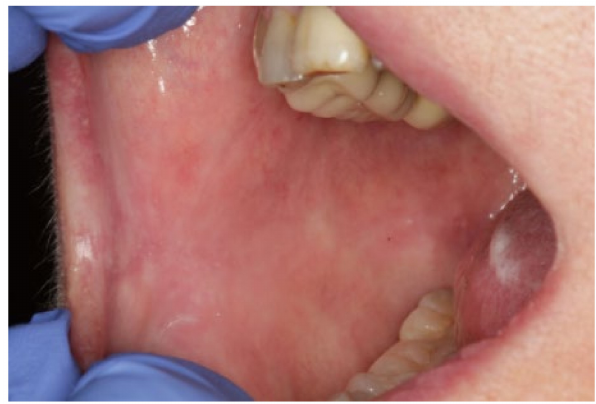
Figure 5. No relapse one year after the last